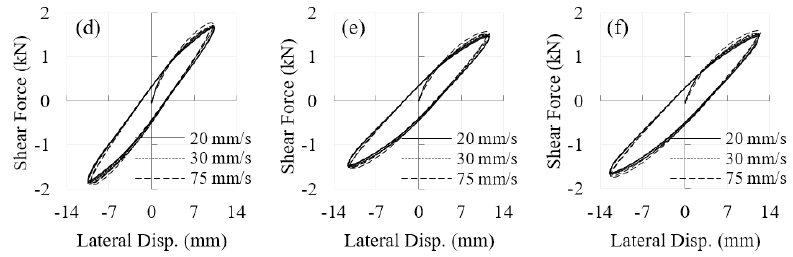
Figure 10. Hysteresis of C-FREIs at different lateral rates (20, 30, and 75 mm/s) and 50% shear strain; Table 3. Effective horizontal stiffness and equivalent viscous damping of C-FREIs at different lateral cyclic rates.